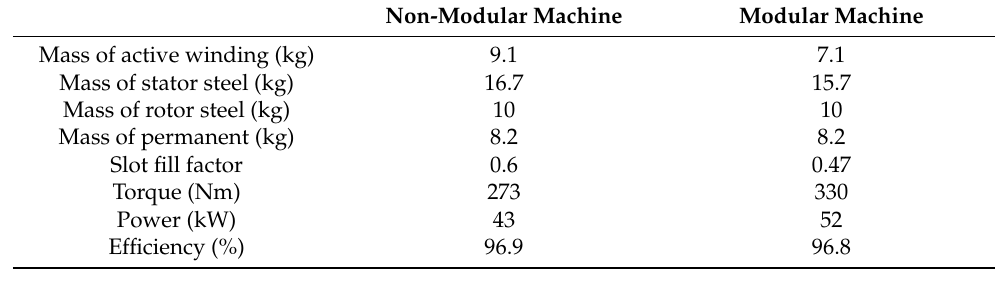
Figure 2. The flowchart of the coupled EM-thermal modelling. T m , T c , B r , H c , and R are the magnet temperature, the coil temperature, the magnet remanence, the magnet coercivity, and the coil re- sistance, respectively. Table 2. Masses of active materials and key EM performance comparisons between the modular and non-modular SPM machine.